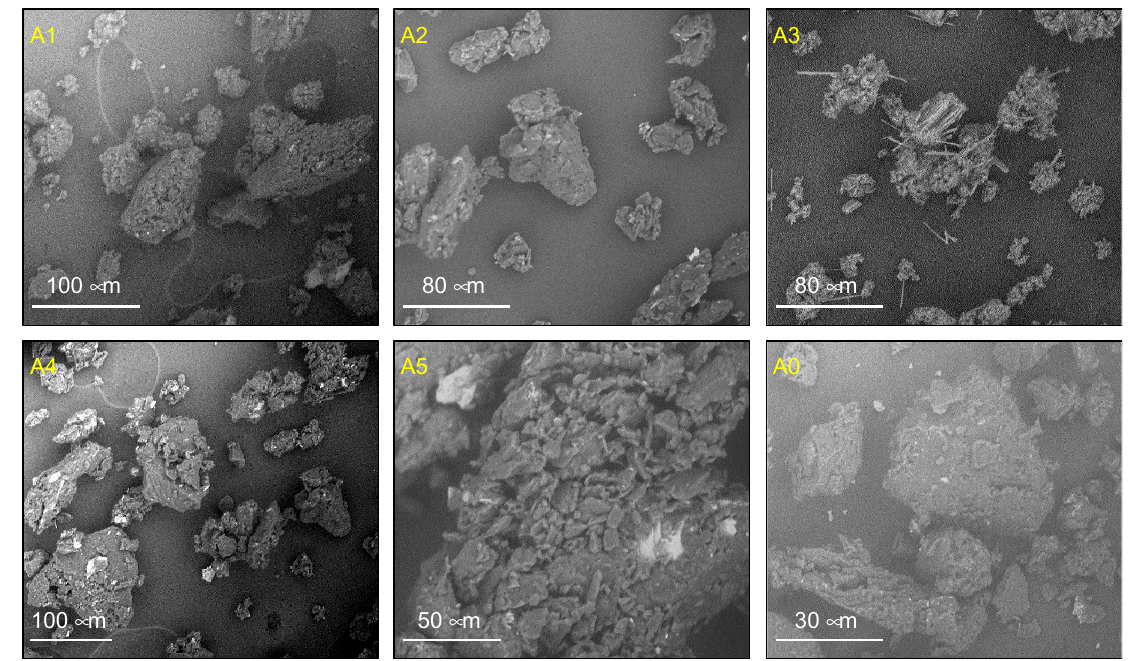
Figure 2. SEM of representative batches of insulin-loaded microparticles (MPs) containing different ratios of mucin to PEG. Formulations: A1 = mucin / PEG / insulin (1:1:15), A2 = mucin / PEG / insulin (1:2:15), A3 = mucin / PEG / insulin (1:3:15), A4 = mucin / PEG / insulin (1:4:15), A5 = mucin / PEG / insulin (1:5:15). Control A0 corresponds to the formulation containing no insulin (mucin / PEG, 1:1). Each formulation is indicated in the top left corner of the corresponding microscopy image.